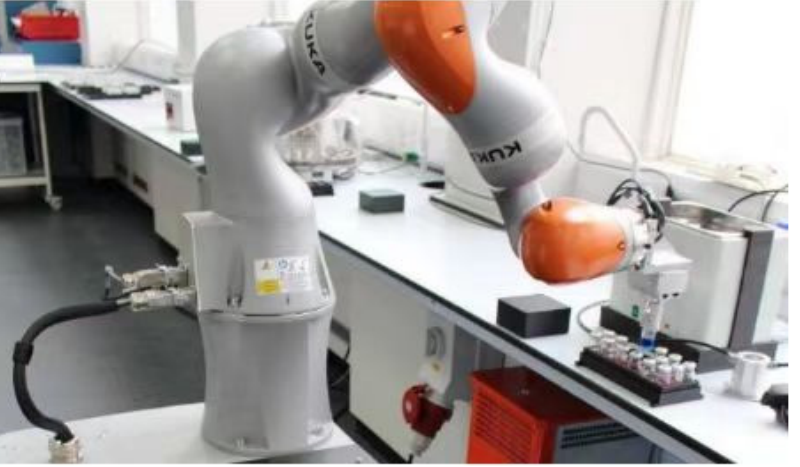
Figure 15. Fully autonomous mobile “Robot Chemist”, Reprinted with permission from ref. [62].